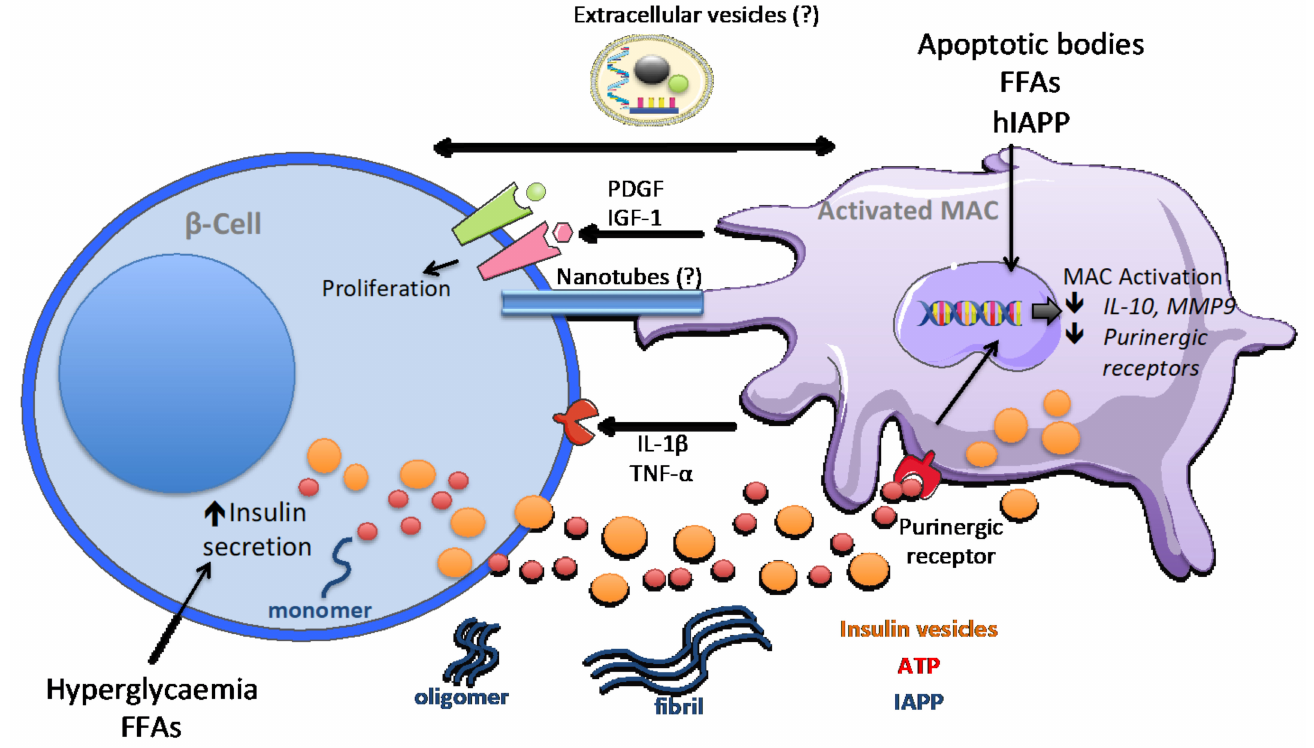
Figure 3. β -cell–macrophage crosstalk in obesity and T2D. Under obesity conditions, β -cells try to compensate over nutrition and hyperglycaemia by releasing more insulin. Macrophages sense the changes in β -cell function via the uptake of insulin vesicles and the hyperactivation of purinergic receptors. This, together with the action of free fatty acids (FFAs), β -cell apoptotic bodies, and hIAPP oligomers and fibrils produced in obese islets activates intracellular processes leading to gene expression modulation. Transcriptional reprogramming triggers the switch in macrophages activation, causing a decrease in IL-10 and MMP9 homeostatic factors and purinergic receptors. Obese macrophages release both growth factors inducing β -cell proliferation and pro-inflammatory cytokines, with a deleterious impact on β -cells. Other proposed routes of communication are tunnelling nanotubes for a direct exchange of cytosolic material and extracellular